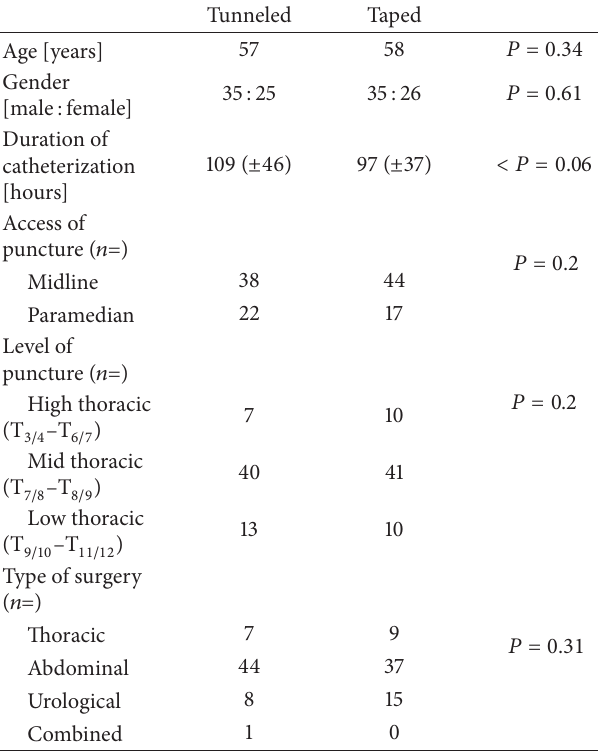
Table 1: General data of study groups (tunneled versus taped).